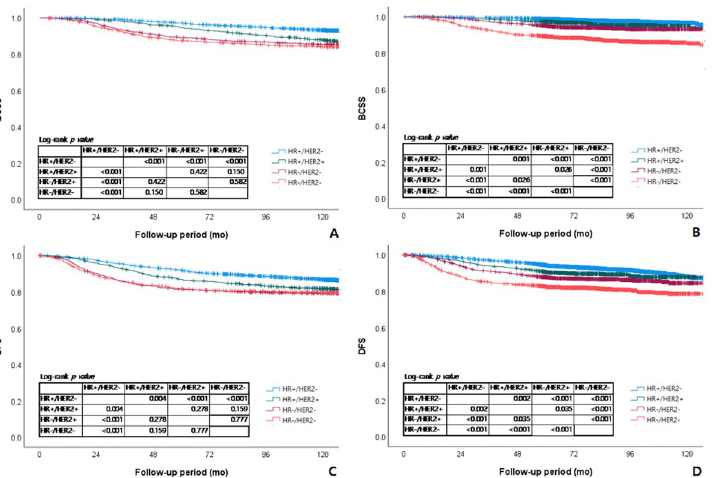
Fig 3. Breast cancer-specific survival (BCSS) and disease-free survival (DFS) in Korean breast cancer patients according to the subtype in each period. (A) BCSS of patients who had surgery between 2000–2007. (B) BCSS of patients who had surgery between 2008–2013. (C) DFS of patients who had surgery between 2000–2007. (D) DFS of patients who had surgery between 2007–2013. HR: hormone receptor; HR(+): estrogen receptor (+) and/or progesterone receptor (+); HER2: human epidermal growth factor receptor